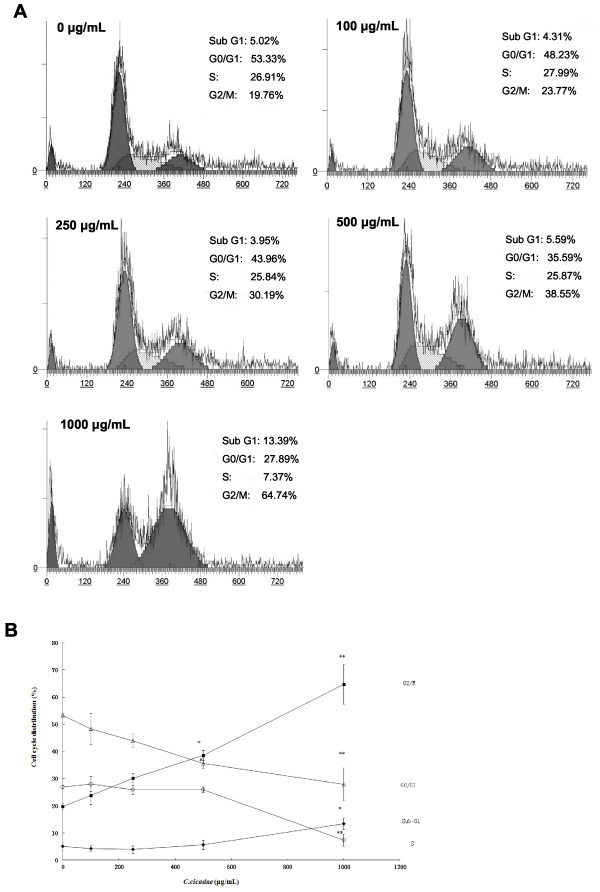
The effects of C. cicadae on MHCC97H cell cycle. (A) Cellular DNA contents in C. cicadae-treated and control cells were monitored by flow cytometry. The cell cycle distribution of sub-G1, G1, S and G2/M phase cells are presented as DNA histogram. (B) The percentage of cells in each cell cycle phase of MHCC97H after C. cicadae treatment were shown. The data were expressed as mean ± SD and were representative of three independent experiments. *, **, P < 0.05, 0.01, vs. control, respectively.